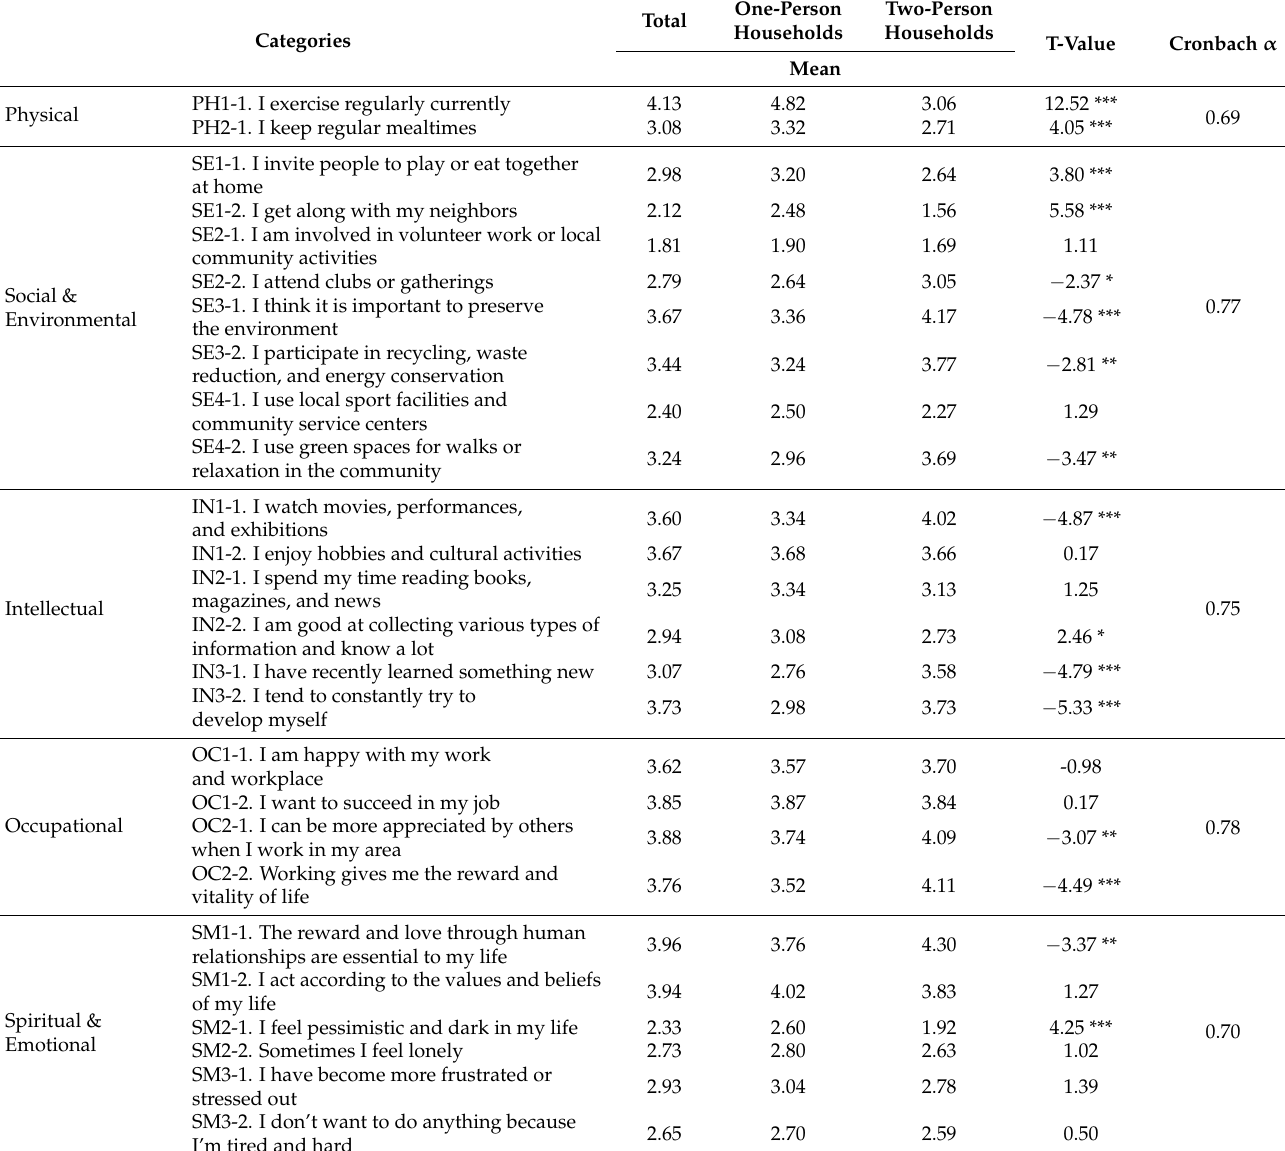
Table 6. Wellness of One-person and Two-person